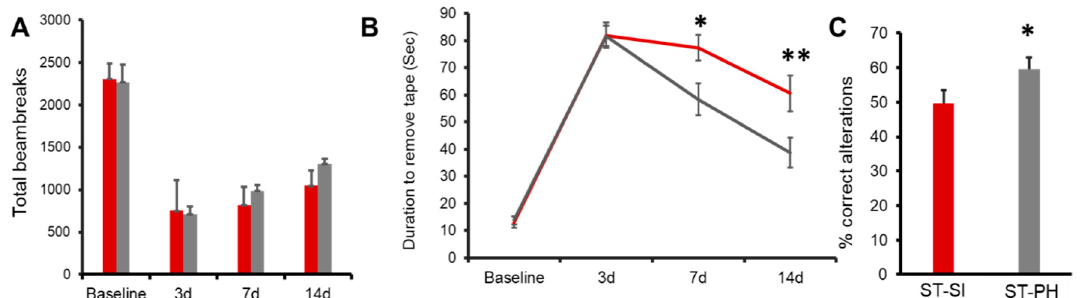
Figure 2. Post-stroke recovery is worse in isolated aged female mice compared to pair-housed mice. ( A ) Repeated open field analysis revealed that SI mice (red) had slower recovery compared to PH mice (grey). Although the SI mice showed no significant difference compared to PH mice, on day 14, the PH mice had a trend towards better locomotor activity compared to the SI mice ( n = 12–13/group). ( B ) SI mice (red) also showed an increase in latency in the adhesive tape removal time compared to PH mice (grey) on day 14. ( n = 12–13/group; * p = 0.020 at day 7, ** p = 0.005 at day 14 ( C ) The SI mice had a lower percentage of complete alteration in the Y-maze compared to the PH mice). ST-PH mice had significantly more% correct alterations compared to ST-SI mice ( n = 12–13/group; * p = 0.05). Data are presented as mean ± SEM. Repeated two-way ANOVA was used to account for within-subject correlation for the repeated measures (A and B). Student’s t-test was used for group comparisons ( C